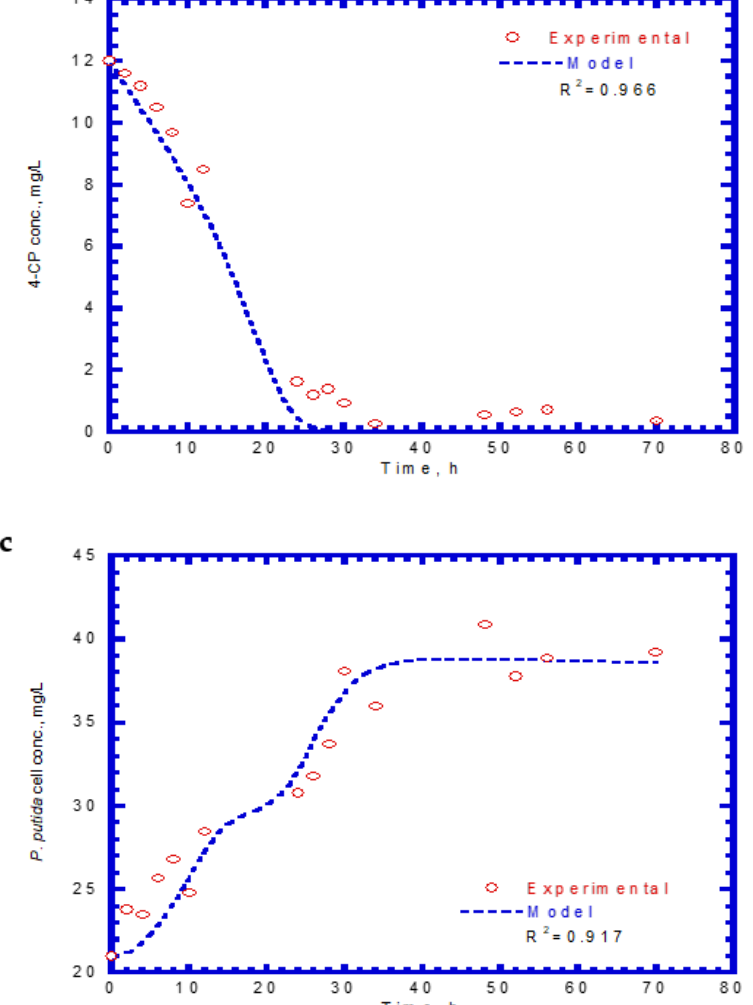
Figure 11. Effluent concentration of SA plus 4-CP in the chemostat system: ( a ) SA, ( b ) 4-CP, and ( c ) cell growth.